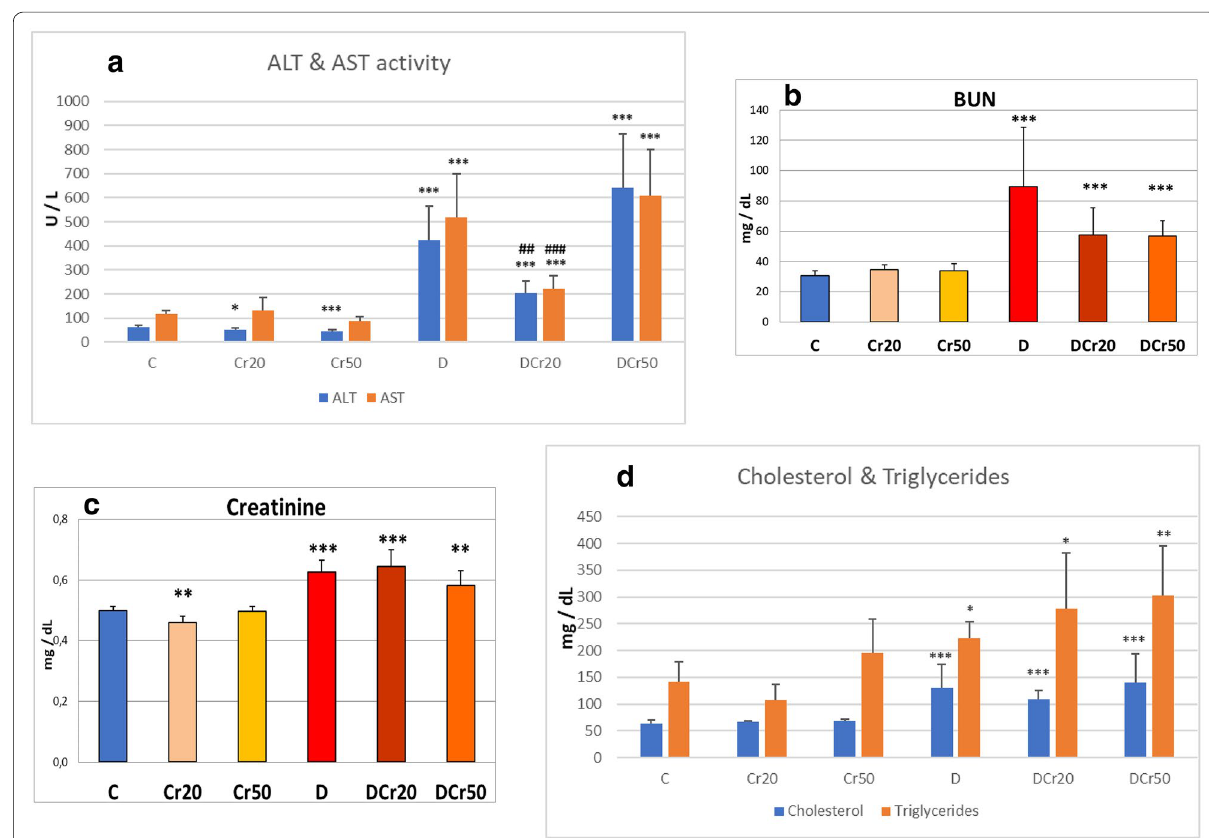
Fig. 1 a ALT and AST activity in serum (mean SD). *( p < 0.05), ***( p < 0.005): statistically significant compared to the C group; ## ( p < 0.01), ± ### ( p < 0.005): statistically significant compared to the D group. b BUN concentration in serum (mean SD). ***Statistically significant compared ± to the C group ( p < 0.005). c Creatinine concentration in serum (mean SD). **Statistically significant compared to the C group ( p < 0.01), ± ***Statistically significant compared to the C group ( p < 0.005). d Cholesterol and triglyceride concentration in serum (mean SD). *( p < 0.05), ± **( p < 0.01), ***( p < 0.005): statistically significant compared to the C